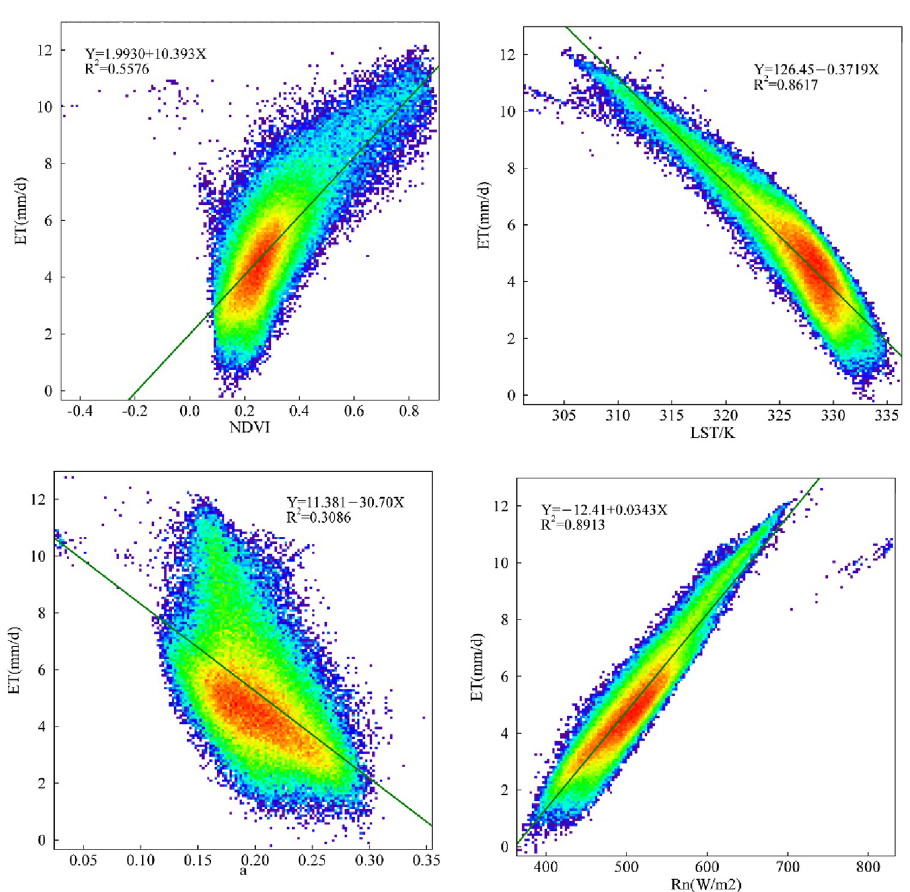
Fig 6. Correlation between the daily evapotranspiration and surface parameters in the agro-pastoral ecotone of northwest China.